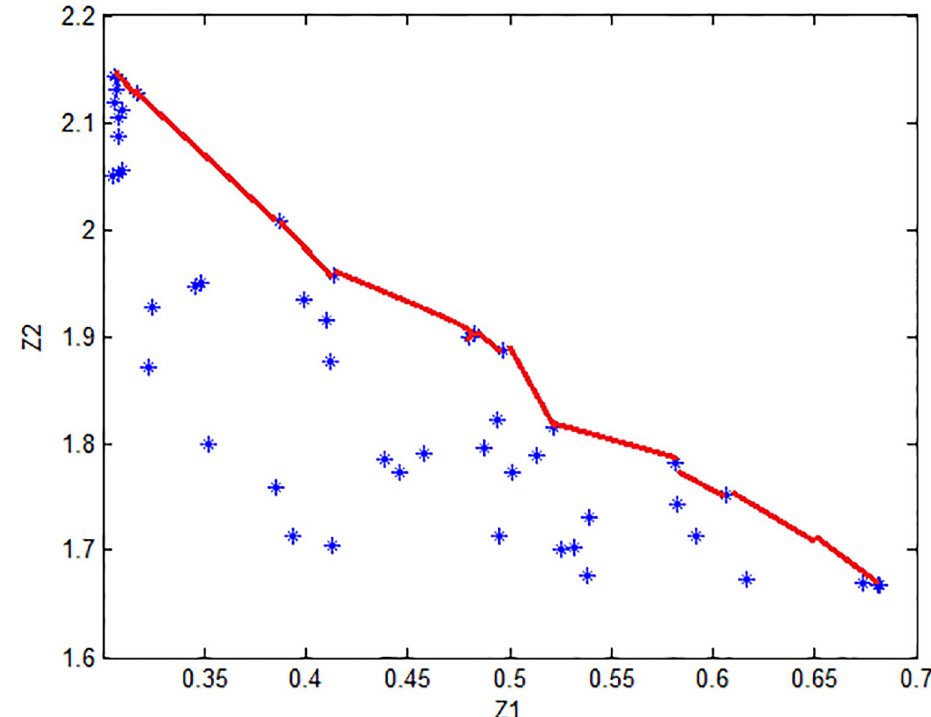
Fig 2. Set of non dominated